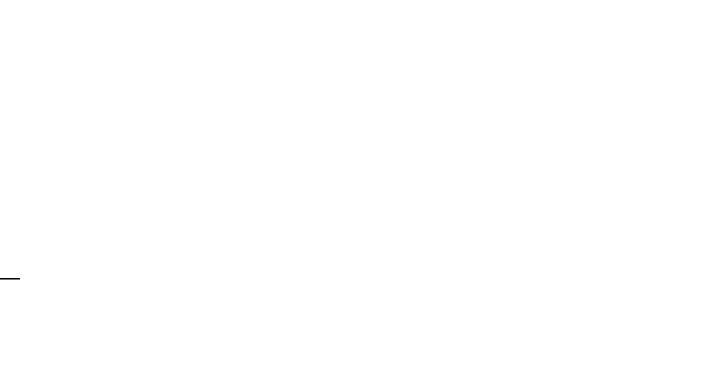
Figure 7. Effect of magnesium sulfate on the oxidative stress marker 8-hydroxy-2 ′ -deoxyguanosine (8-OhdG) in the hippocampi of rats exposed to chronic restraint stress (CRS). Administration of magnesium sulfate lowered the increased levels of 8-OHdG [F (3, 20) = 250.7, p < 0.0001] in the hippocampi of rats exposed to CRS. Values are expressed as the mean of 6 rats ± standard deviation (S.D.). Statistical analysis was applied using one-way ANOVA followed by Tukey’s post-hoc test. Significant differences versus control animals are denoted by ** p < 0.01, or **** p < 0.001. Significant differences versus CRS group are denoted by # ### p < 0.001. CRS, chronic restraint stress; MgSO 4 , magnesium sulfate.